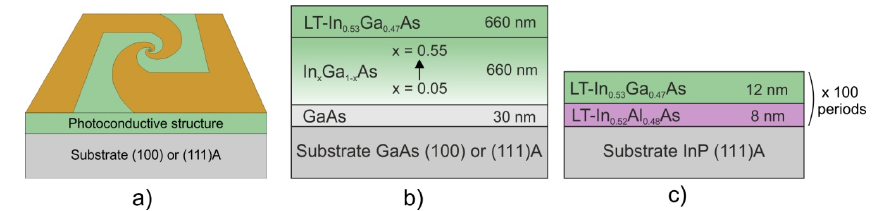
Figure 1. Schematic of the investigated photoconductive semiconductor antenna (PCA) THz emitters: ( a ) topology of spiral antenna, ( b ) LT-InGaAs/GaAs (100) and (111)A heterostructures, ( c ) LT-InGaAs/InAlAs/InP (111)A heterostructure.